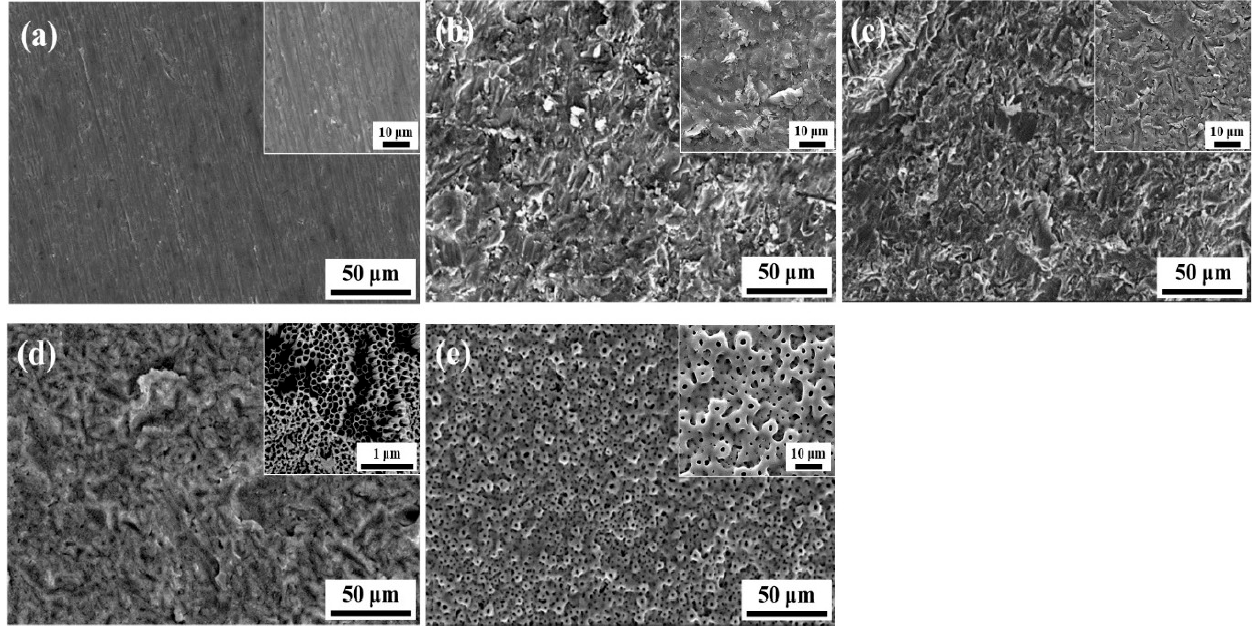
Figure 26. The surface texture of ( a ) Ti has been subjected to a variety of processes, including ( b ) HA blasting, ( c ) SLA, ( d ) AO, and ( e ) MAO. Reprinted with permission from [84]. Copyright 2021 MDPI. Distributed under Creative Commons Attribution-based license (CCBY 4.0.).